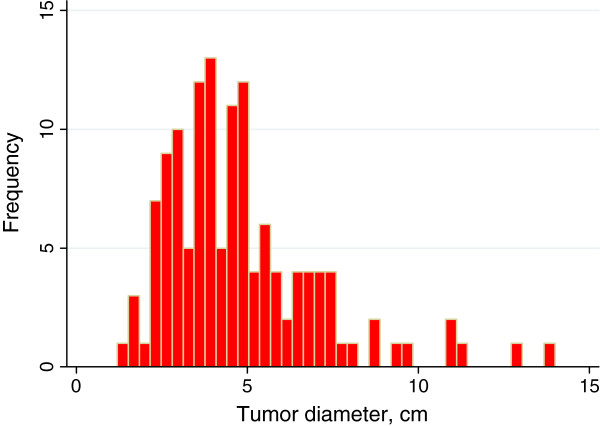
Distribution of the primary tumor's greatest diameter in 132 patients.